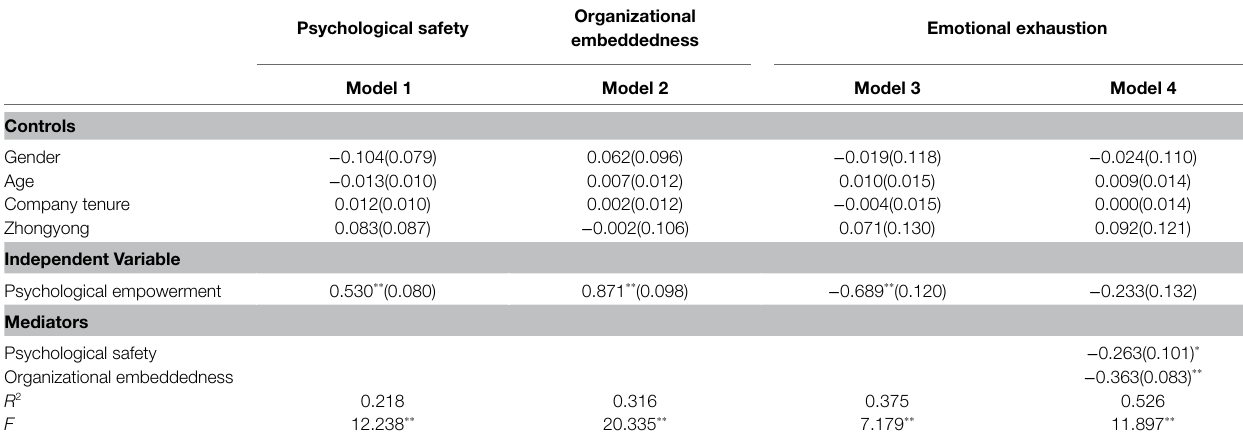
TABLE 3 | Results of mediated regression